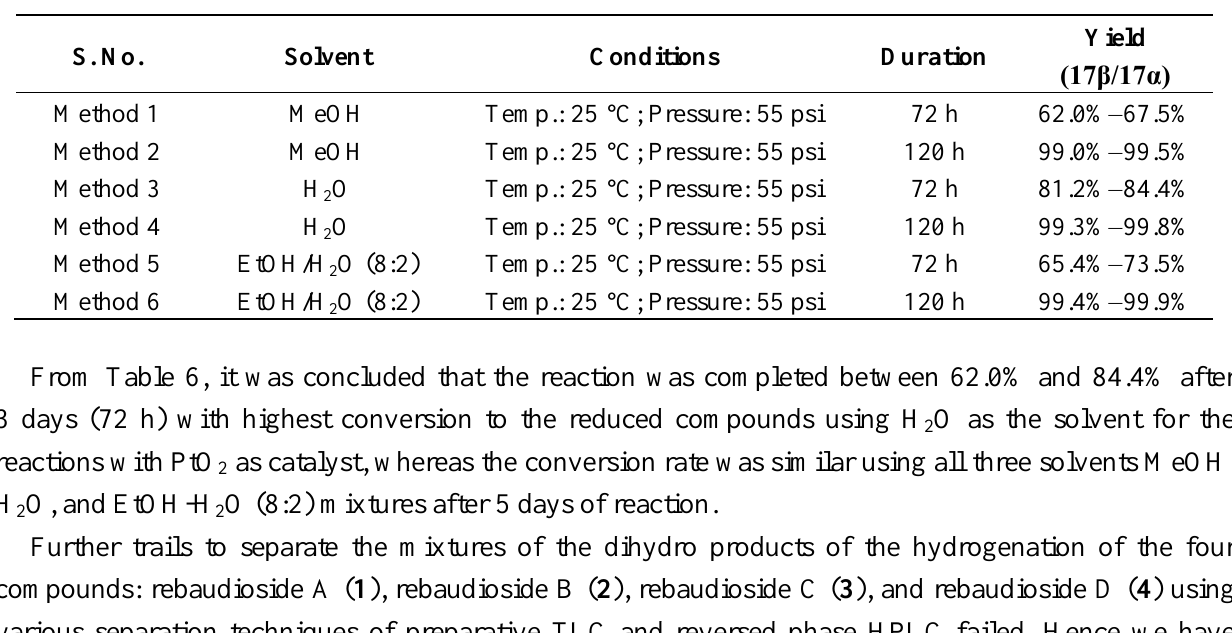
and yields of various methods. 2